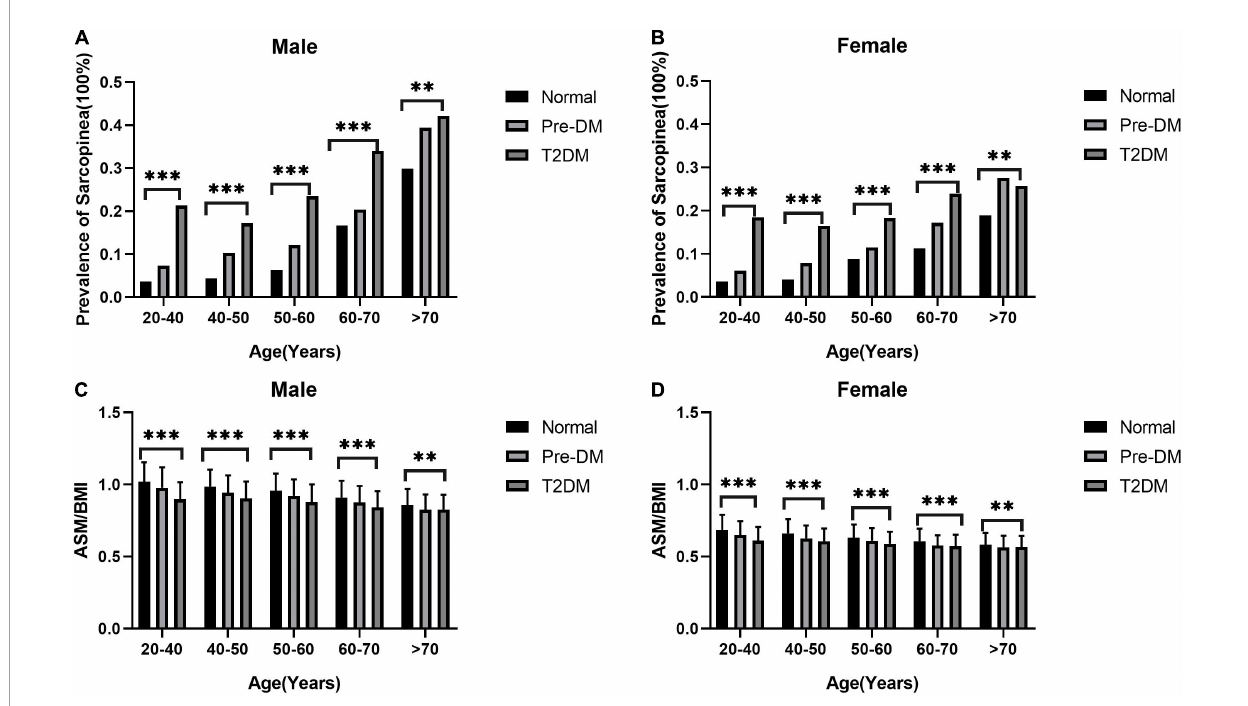
FIGURE2 The prevalence of sarcopenia increases with age and ASM/BMI decreases. The columns in panels (A,B) represent the prevalence of sarcopenia in different groups of diabetes status. The columns in panels (C,D) represent the mean and standard deviation of ASM/BMI in different groups of diabetes status. The difference of ASM/BMI and prevalence of sarcopenia in different age groups with different diabetes status was calculated by analysis of variance. ∗∗∗ p < 0.001 and ∗∗ p < 0.01.